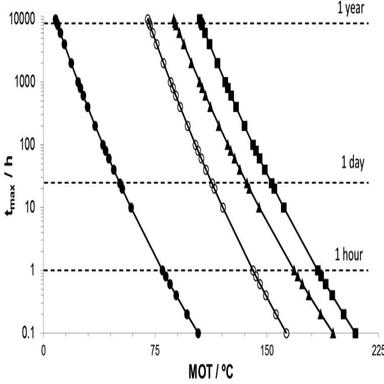
Calculation of the maximum operation temperature (MOT) in air atmosphere of the four selected ILs: . s. ▲ and j, depending on the operating time.